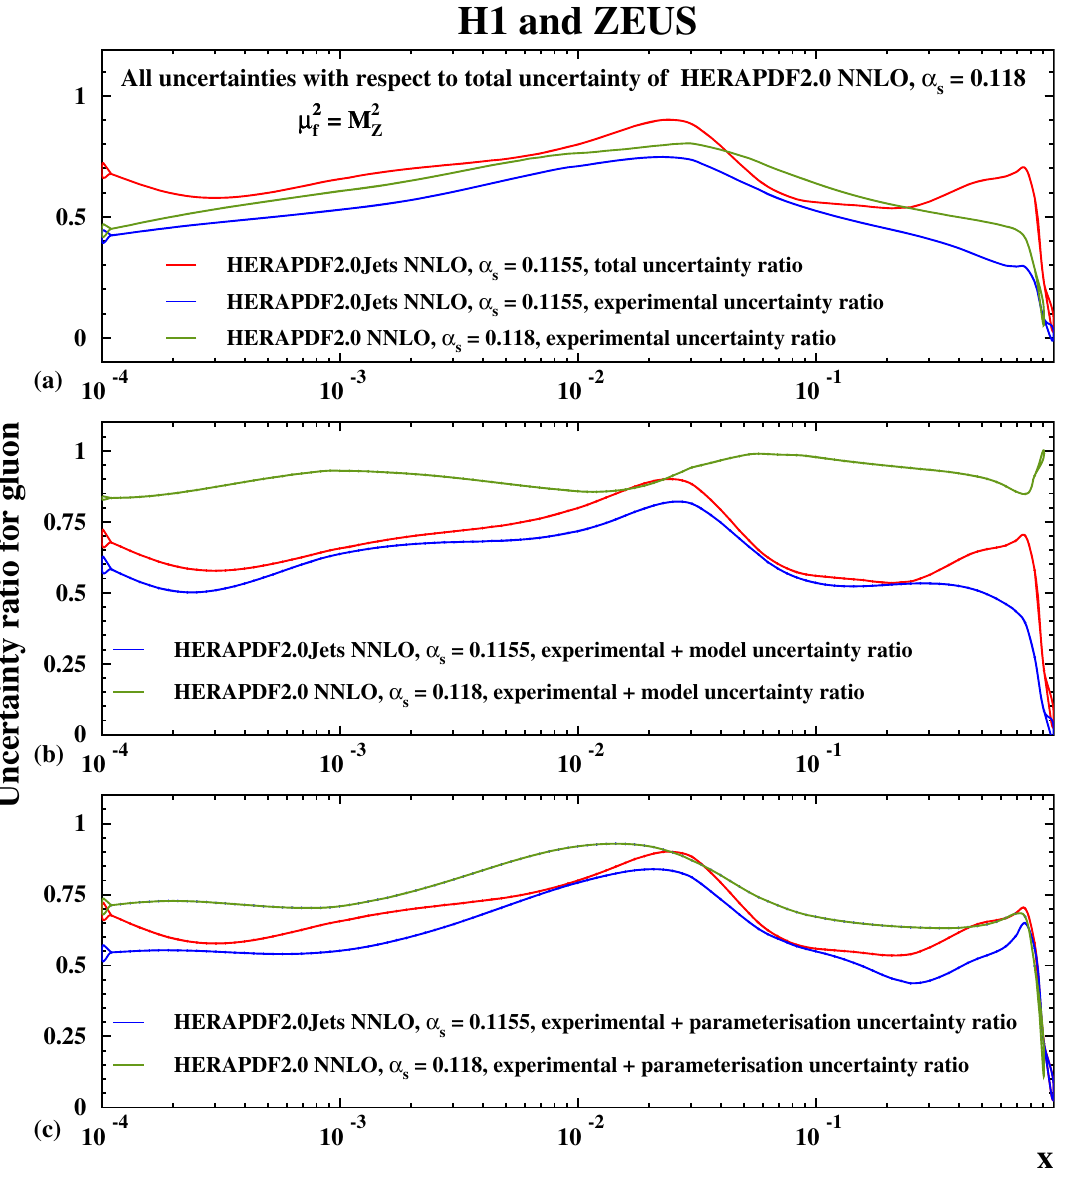
) = 0 . 1155 Z ) = 0 . 118 at the scale Z